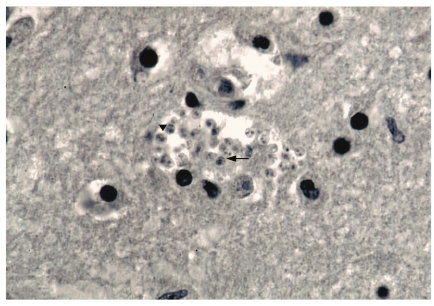
Figure3:Gliomesenchymalclustershowingmicroorganismsof1.5– 3 𝜇 m wide with the morphology of amastigotes, ( 󳶃 ) free and ( → ) inside cytoplasm of a macrophage (H/E, × 400).